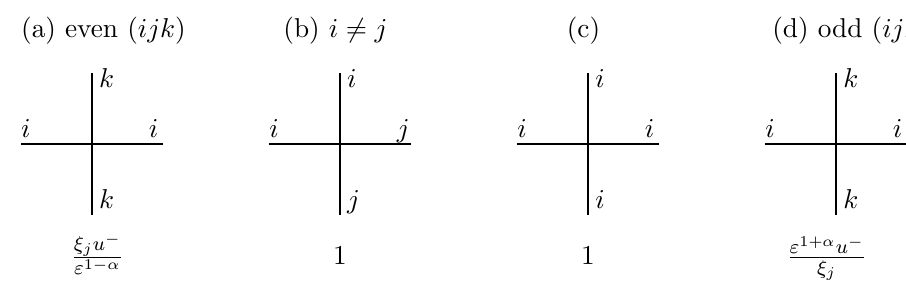
Figure 1 . The Boltzmann weights of ˜R a,‘ for Bethe roots of the class (I).